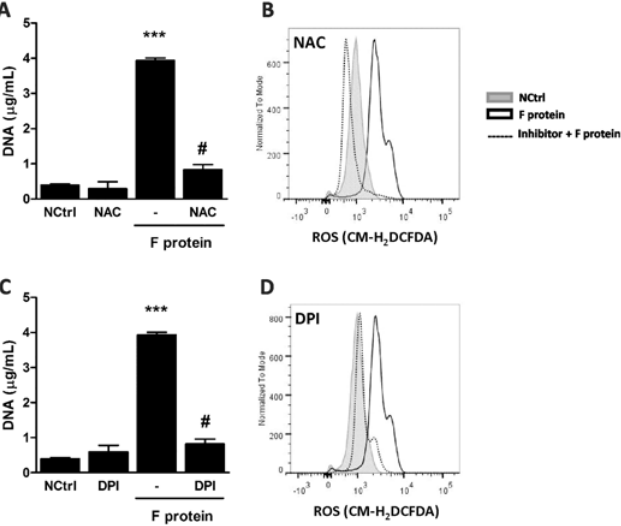
Fig 4. Essential role for NADPH Oxidase-derived ROS on F protein-induced NET generation. (A,C) Neutrophils (2 x 10 6 /mL) were pretreated with NAC (1 mM) or DPI (10 μ M) for 1 h and stimulated with F protein (1 μ g/mL) for 3 h at 37°C with 5% CO 2 . NETs were quantified in culture supernatants using Quant-iT dsDNA HS kit. Data are representative of 3 separate experiments performed in triplicates and represent mean ± SEM. *** p < 0.001 when compared to negative control (NCtrl); #p < 0.001 when compared to F protein-treated cells. (B,D) Neutrophils (2 x 10 6 /microtube) were pretreated with NAC (1 mM) or DPI (10 μ M) for 1 h, stimulated with F protein (1 μ g/mL) for 1 h at 37°C with 5% CO 2 and incubated with 0.5 μ M CM-H 2 DCFDA for 30 min. ROS generation was analyzed by flow cytometry using FACSCanto II flow cytometer. Neutrophils gate was based on FSC x SSC distribution. Data are representative of 2 independent experiments performed in triplicates with similar